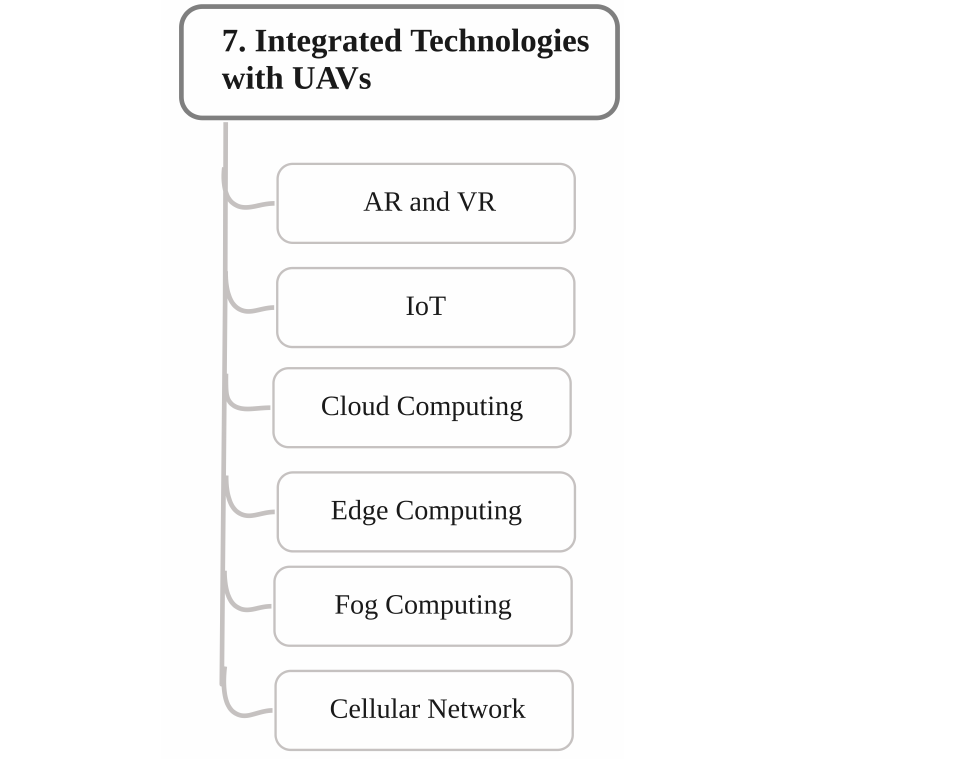
Figure 6. The main technologies integrated with UAVs: augmented and virtual reality (AR and VR), IoT, cloud, edge, and fog computing, and cellular